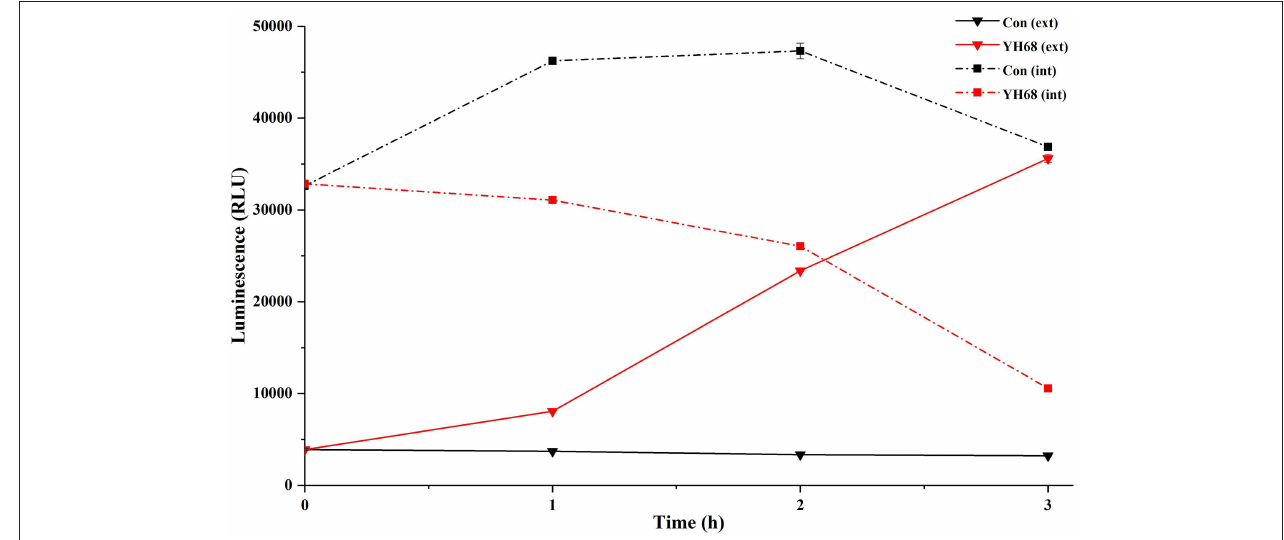
FIGURE 6 | Intracellular (int) and extracellular (ext) ATP levels in C. difficile ATCC 9689 cells.